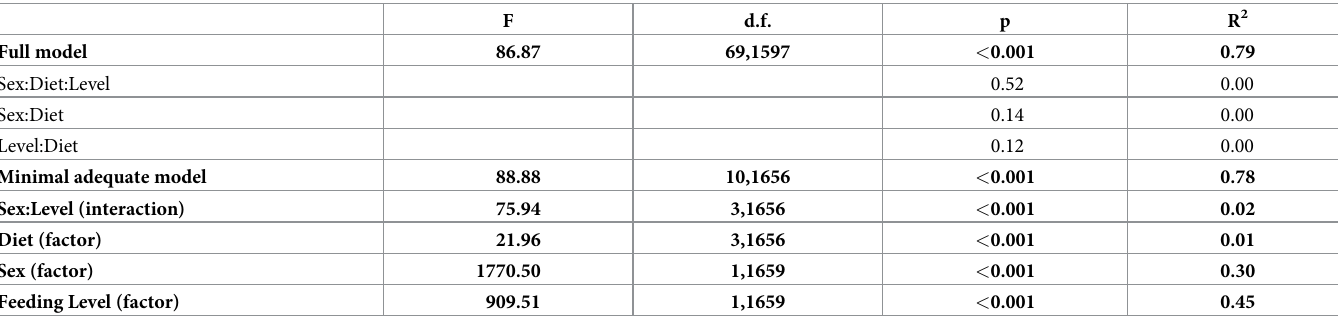
Table 6. Aedes aegypti weight statistics with significant effects shown in